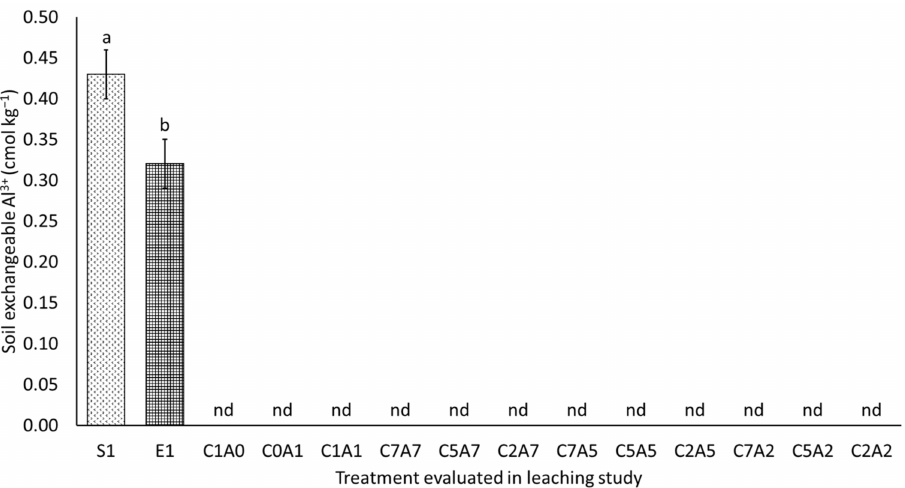
Figure 8. Treatments on soil exchangeable aluminium after thirty days of leaching, where S1: soil only; E1: soil with ERP only; C1: 100% charcoal; C0: 0% charcoal; C7: 75% charcoal; C5: 50% charcoal; C2: 25% charcoal; A1: 100% sago bark ash; A0: 0% sago bark ash; A7: 75% sago bark ash; A5: 50% sago bark ash; A2: 25% sago bark ash. Means with different letter(s) indicate significant differences between treatments according to Tukey’s HSD test at p ≤ 0.05, that is, a > b. Bars represent the mean values ± SE. nd: not detected.